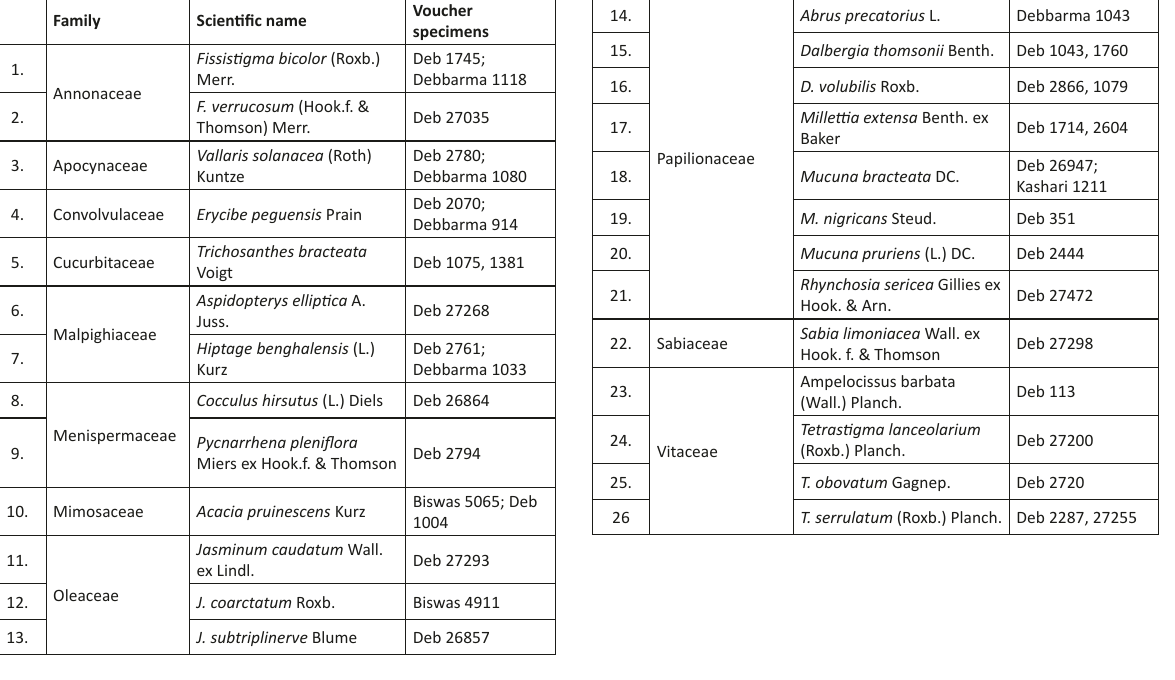
Table 2. The species of lianas which could not be traced in the field during recent explorations in